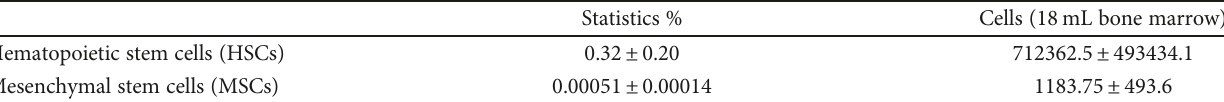
Table 3: The relative percentage of various BM cell populations.